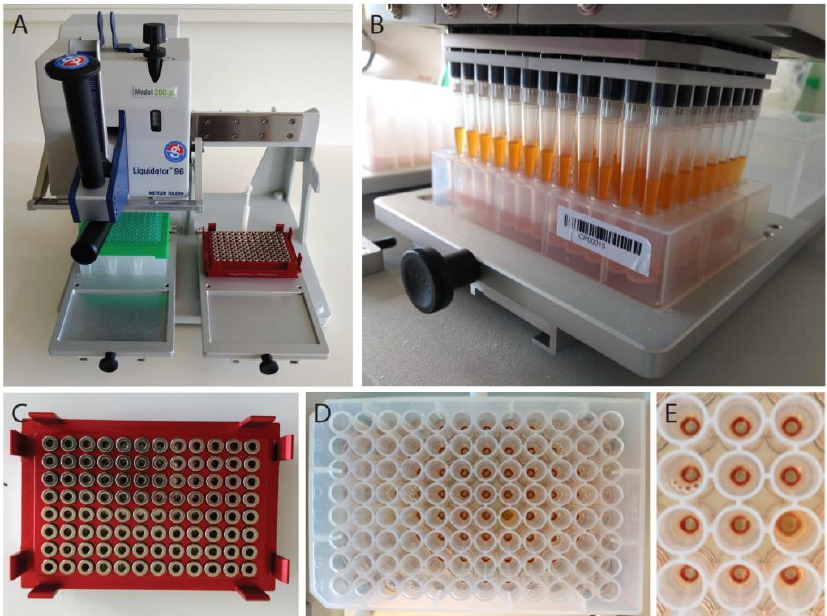
Figure 1. Magnetic bead RNA extraction using the Liquidator 96 pipetting system. ( A ) Liquidator 96, Model 200 µL, tip box is placed in the rear left position and magnet plate (red) in the rear right position. ( B ) The liquidator is used to resuspend magnetic beads in the 96-deep-well plate. ( C ) Magnet plate used to separate the magnetic beads and the supernatant. ( D , E ) Ring-shaped pellets are formed after placing the 96-deep-well plate onto the magnetic ring plate ( C ) for 10 min.